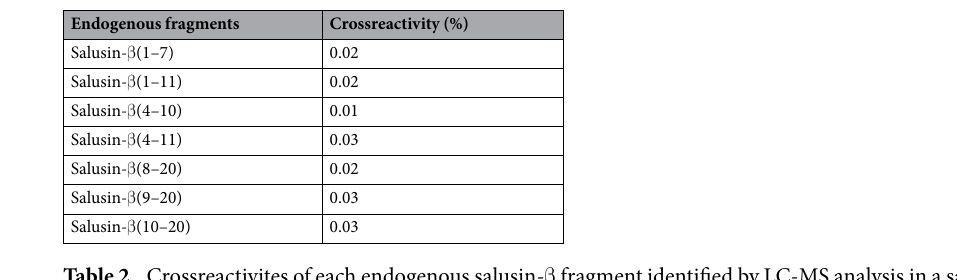
Table 2. Crossreactivites of each endogenous salusin- β fragment identified by LC-MS analysis in a salusin- β sandwich